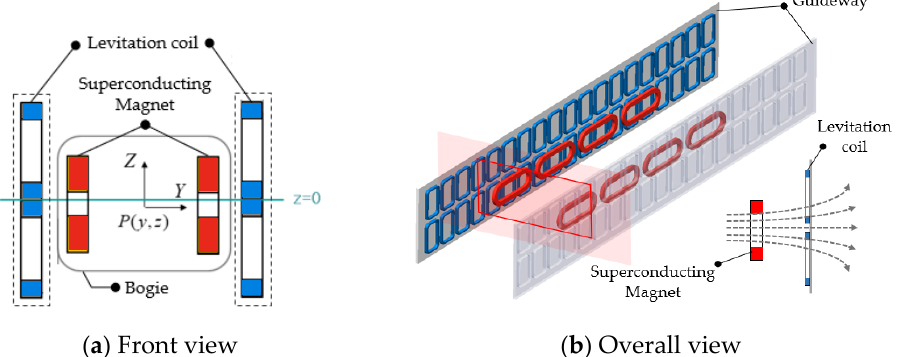
Figure 2. Arrangement of superconducting magnets and levitation coil.